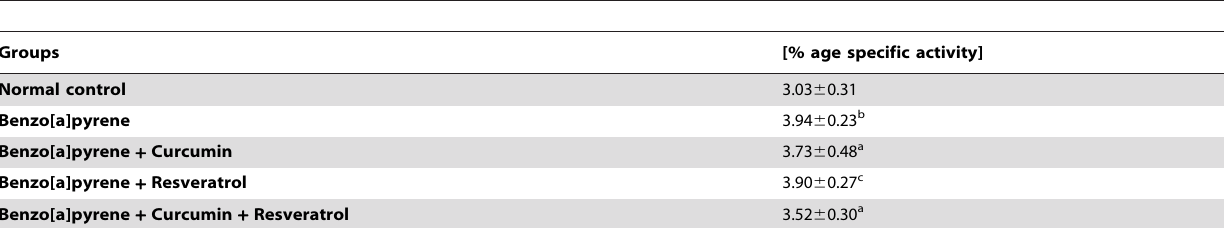
Table 4. Effects of curcumin and resveratrol treatments on the in vitro 3 H-thymidine uptake in lungs during benzo[a]pyrene induced lung